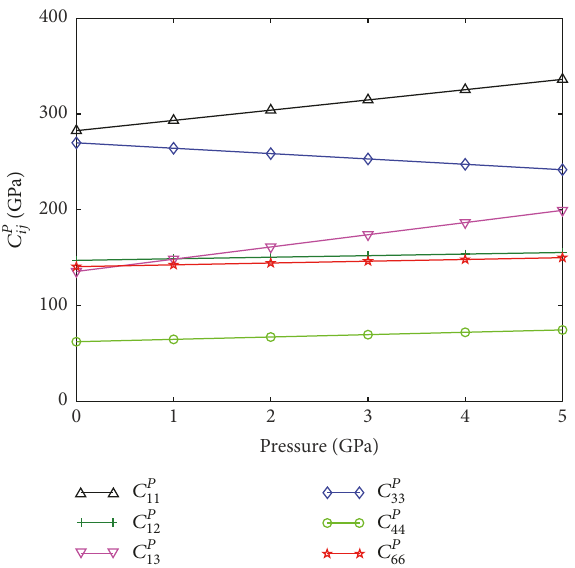
Figure 4: The effective second-order elastic constants ( 𝐶 𝑃 𝑖𝑗 ) versus pressure ( 𝑃 ) of tetragonal YNi 2 B 2 C.